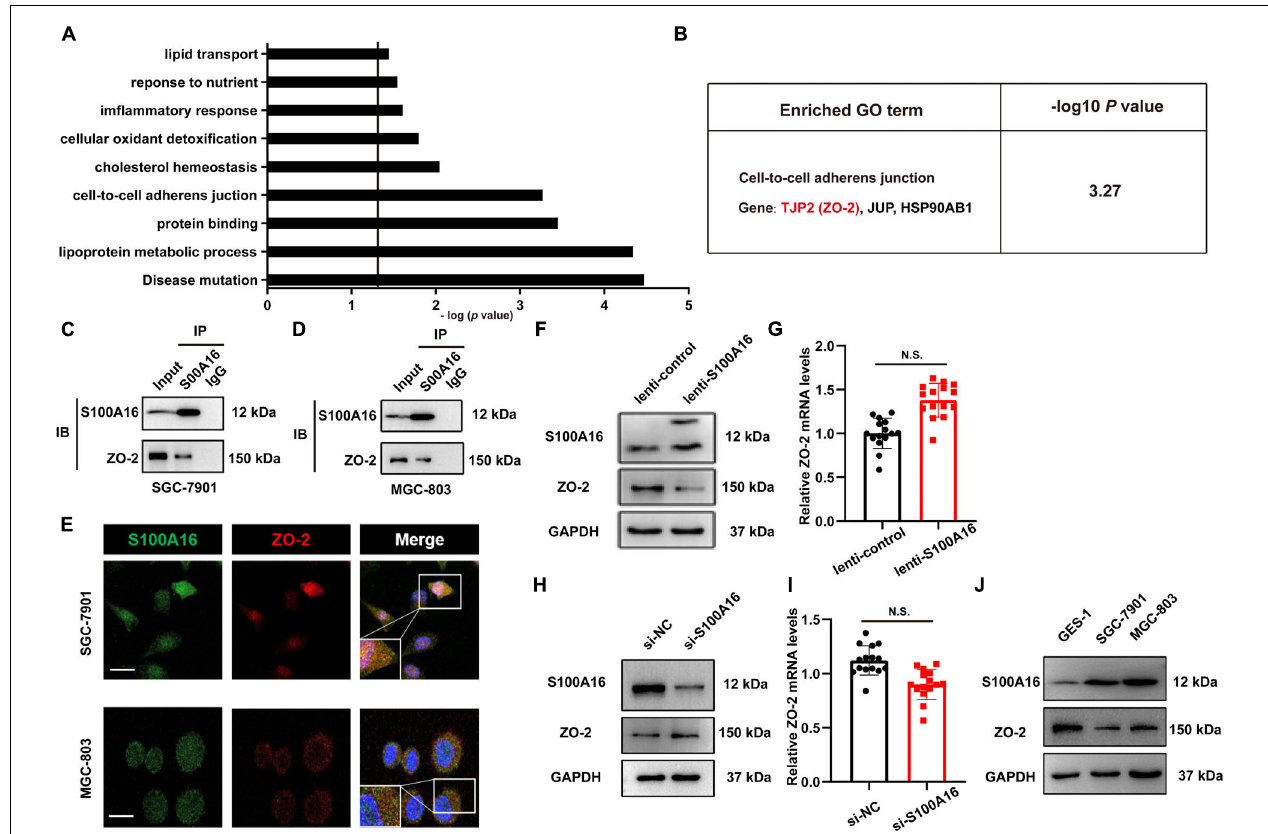
FIGURE 6 | S100A16 and ZO-2 interact directly and their expression levels are inversely correlated in GC cells. (A) DAVID Bioinformatics Resources 6.7 was used to perform GO analysis of S100A16-binding proteins in SGC-7901 cells transfected with lenti-S100A16 or lenti-control (A). Relative cellular processes were sorted by − log ( P -value). P -value < 0.05; − log ( P -value) > 1.3. (B) A cluster of genes (ZO-2, JUP, HSP90AB1) associated with the cell-to cell adherens junction (B) was sorted out. (C,D) Validation of the interactions between endogenous S100A16 and ZO-2 in SGC-7901 (C) and MGC-803 cells (D) . (E) ZO-2 co-localizes with S100A16 in gastric cancer cells. Immunofluorescence staining was performed for ZO-2 (red), S100A16 (green), and DAPI (blue). Scale bars = 10 µ m. (F) The whole cell protein levels of S100A16 in SGC-7901 cells stably overexpressing S100A16 were measured through Western blot analysis. (G) ZO-2 mRNA level in SGC-7901 cells in panel (F) was detected via qRT-PCR assay. (H) The whole cell protein levels of S100A16 in SGC-7901 cells transfected with si-negative control (NC) or si-S100A16 for 60 h were measured through Western blot analysis. (I) ZO-2 mRNA level in SGC-7901 cells in panel (H) was detected via qRT-PCR assay. (J) The expression of S100A16 and ZO-2 in GES-1, SGC-7901, and MGC-803